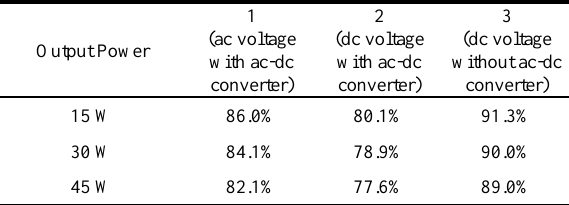
Table 4. Power and efficiency comparison for the three cases obtained with the experimental